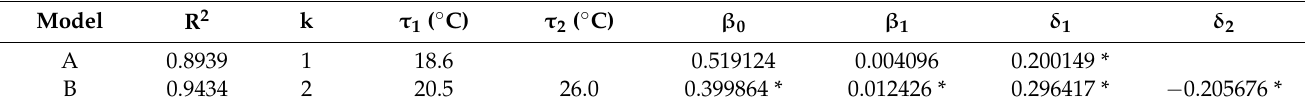
Figure 7. Fitting results of the JPR models (*: p < 0.05). Table 1. Parameters of the four JPR models.